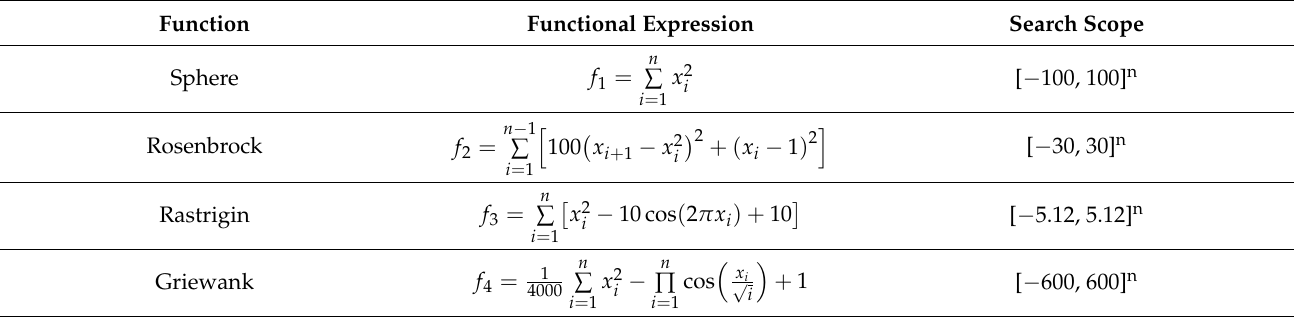
Table 2. Information about each